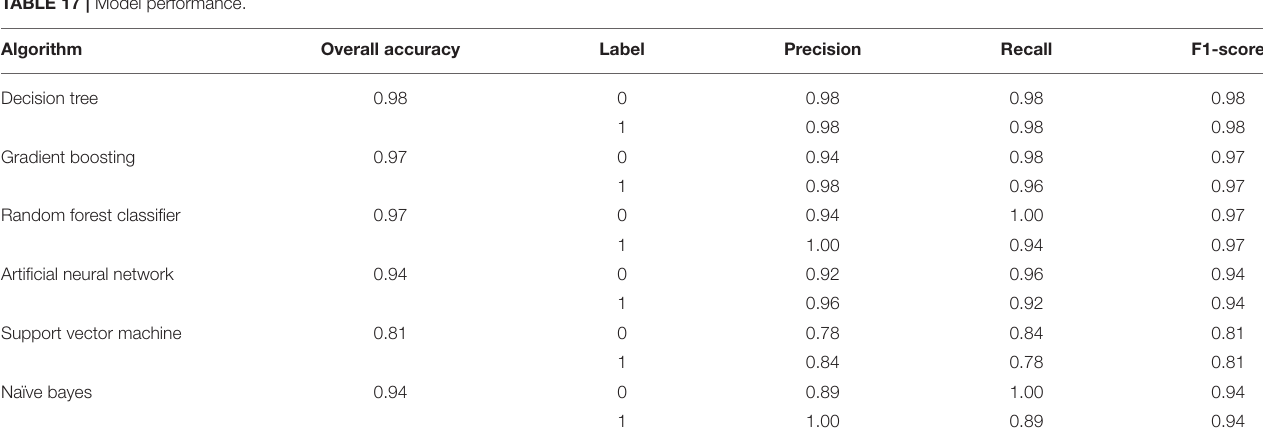
TABLE 17 | Model performance. Algorithm Overall accuracy Label